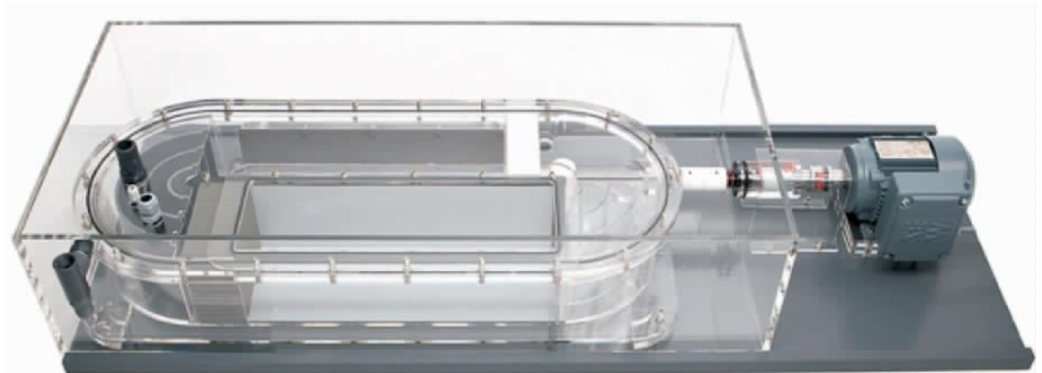
Figure 1. Swim tunnel respirometer (SW10200, Loligo Systems, Denmark).